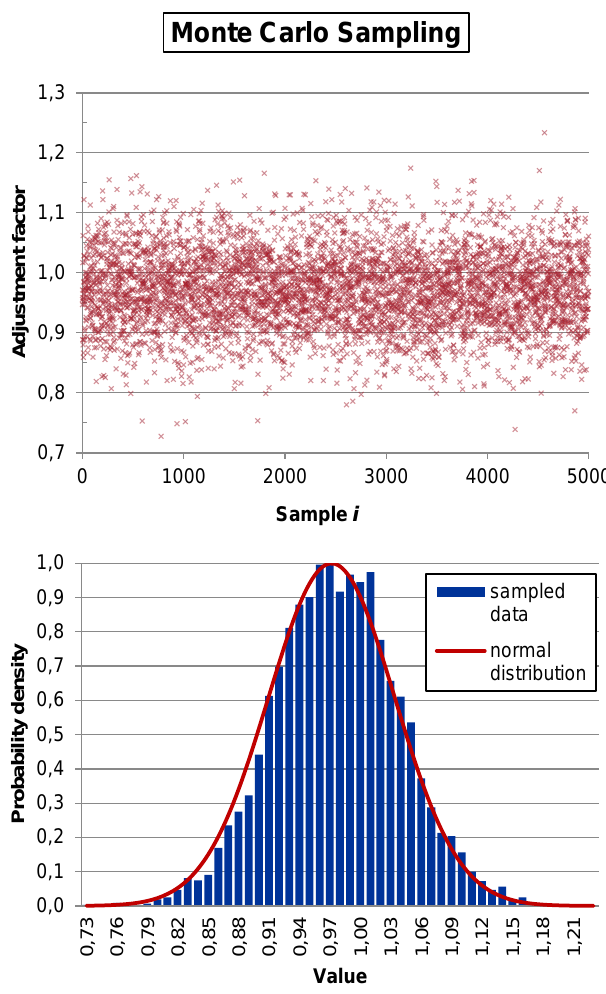
Fig. 4. Example of adjustment factor sampling for U-235 in one of the pins and its probability density function. In this case, the factor was sampled according to normal distribution with mean μ = 0.97 and deviation σ =